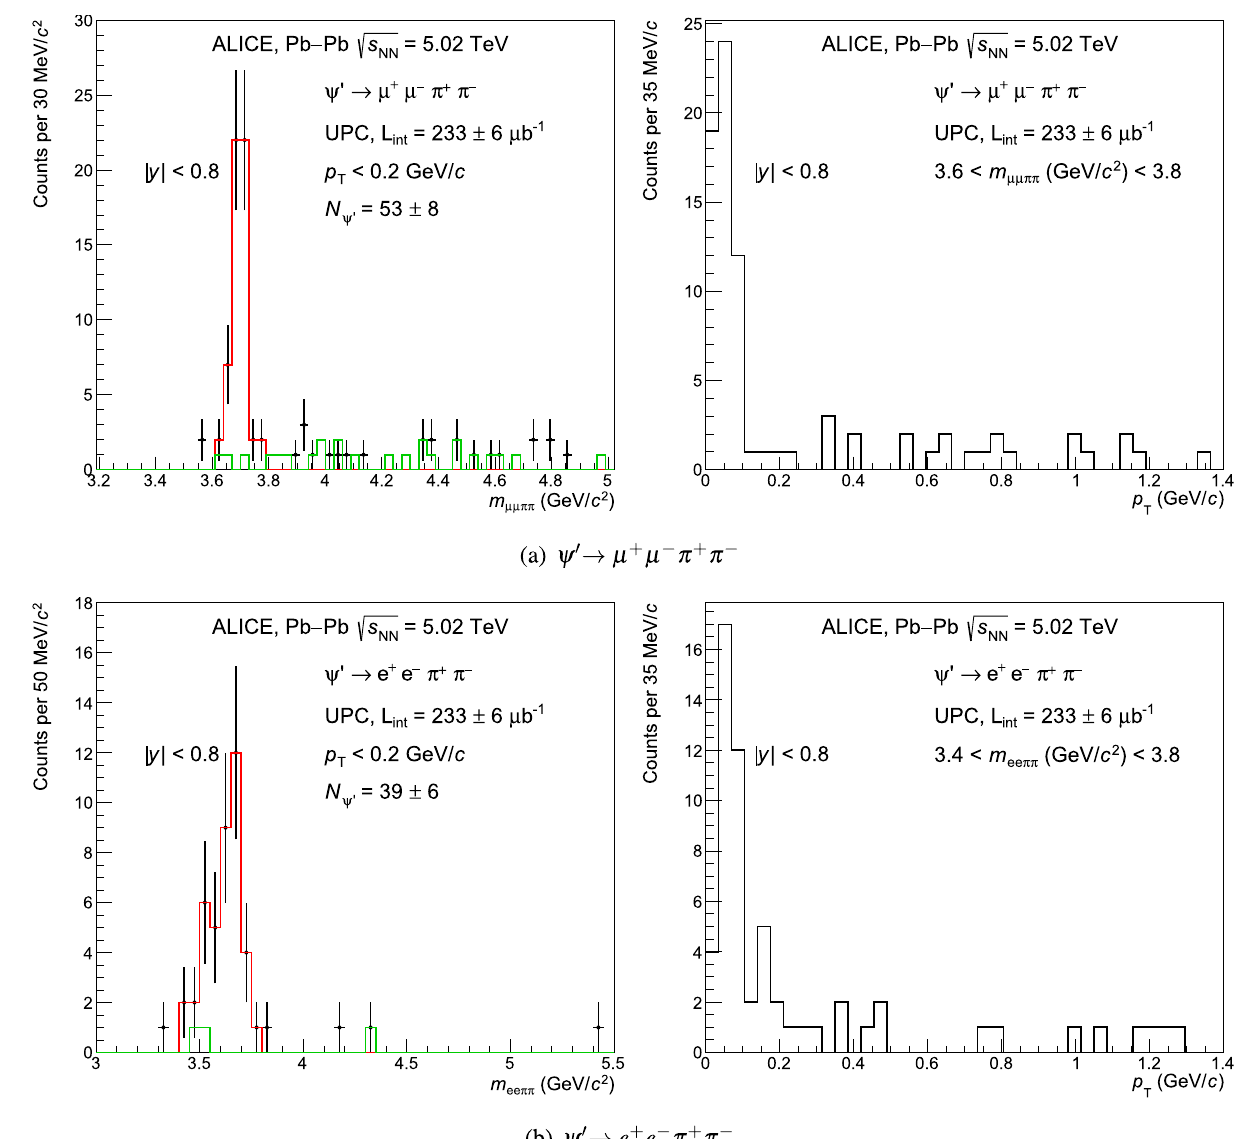
Fig. 4 Left: Invariant mass distribution for ψ (cid:2) → μ + μ − π + π − (upper panel) and ψ (cid:2) → e + e − π + π − (bottom panel). The green line shows the wrong sign four-track events. The red line shows the ψ (cid:2) signal